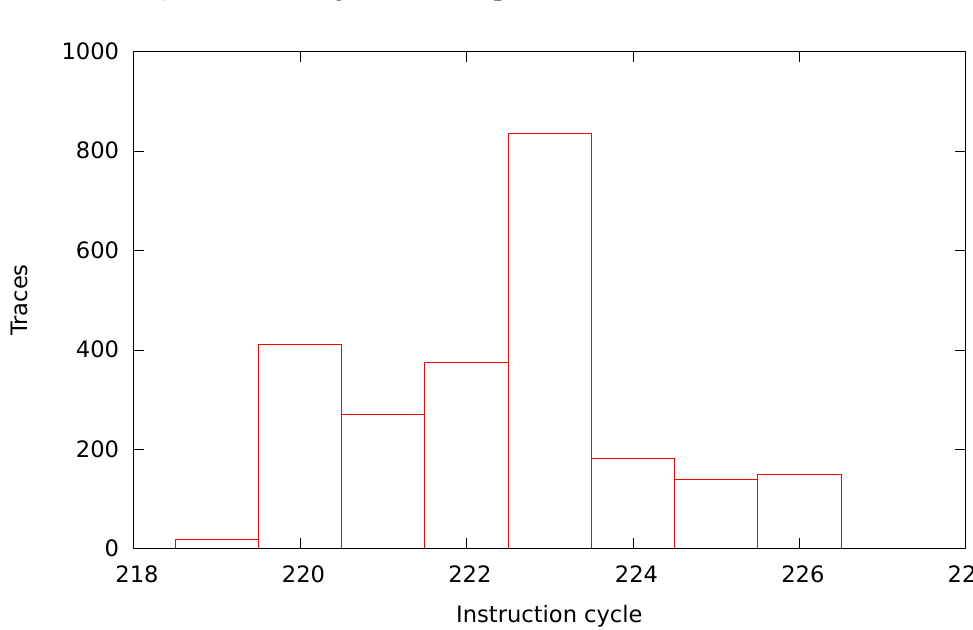
Figure 10. Histogram of manipulation of intermediate